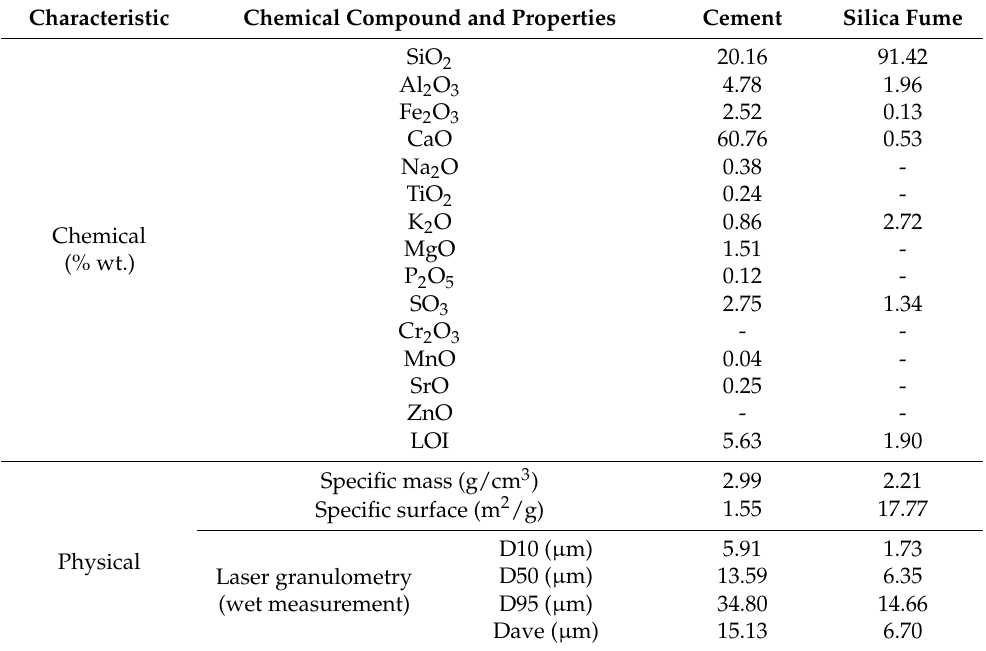
Table 1. Chemical and physical characteristics of the materials.